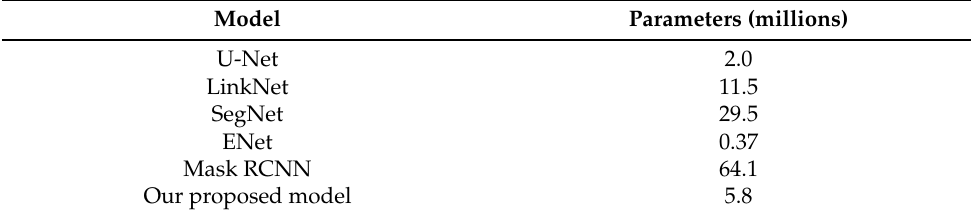
Table 4. The number of parameters in the